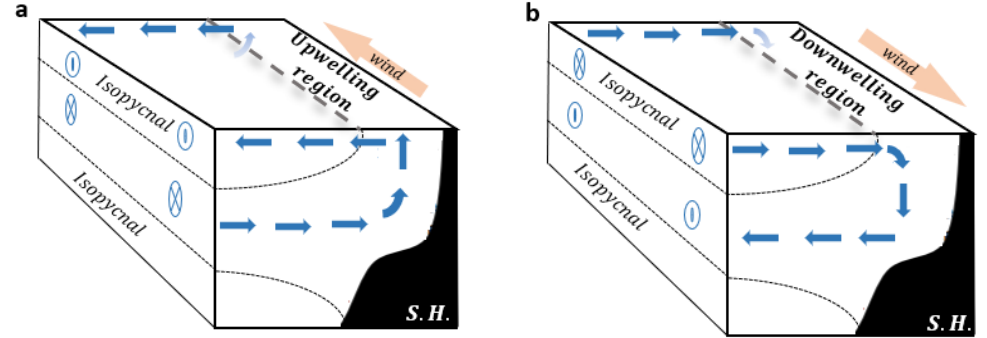
Figure 1. Description of the deviation of surface water masses for the southern hemisphere (SH). The left side shows the upwelling processes, and the right side shows the descent processes of the water masses. Upwelling process is depicted in ( a ) while a scheme for downwelling is presented in ( b ). The opposite effect, sinks or downwelling, occurs when the water is transported towards the coast [8], as shown in Figure 1b. The mentioned processes facilitate the deep ocean’s oxygenation by transporting dissolved oxygen from the surface throughout the water column. Vertical movements are essential for biological productivity in the sea and therefore contribute directly to conserving the marine ecosystem